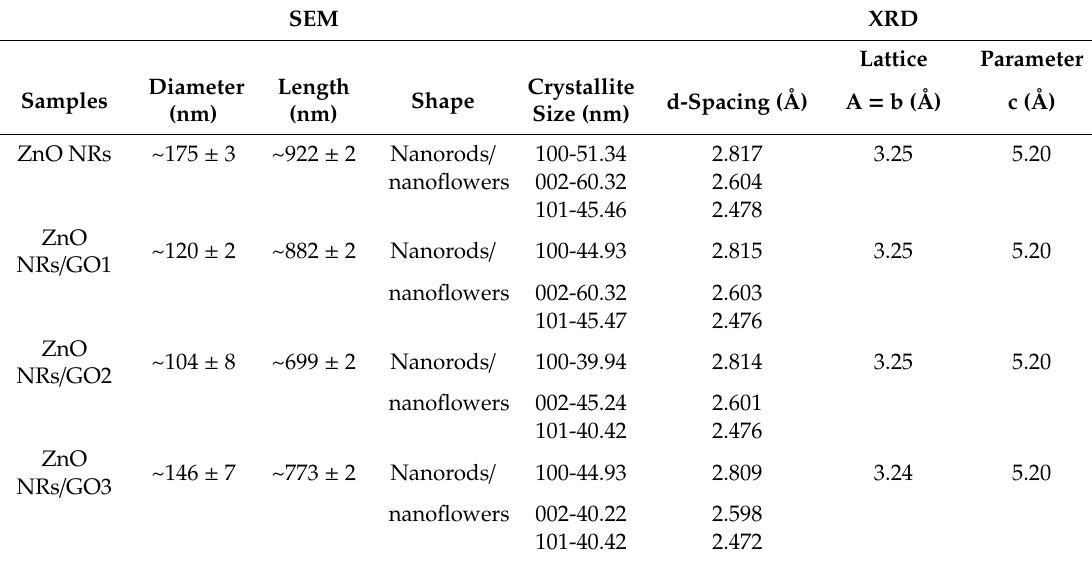
Table 1. Values of average diameter, length, with the standard deviations of the distributions, crystallite size, d-spacing, and lattice parameters of ZnO NRs and ZnO NRs / GO